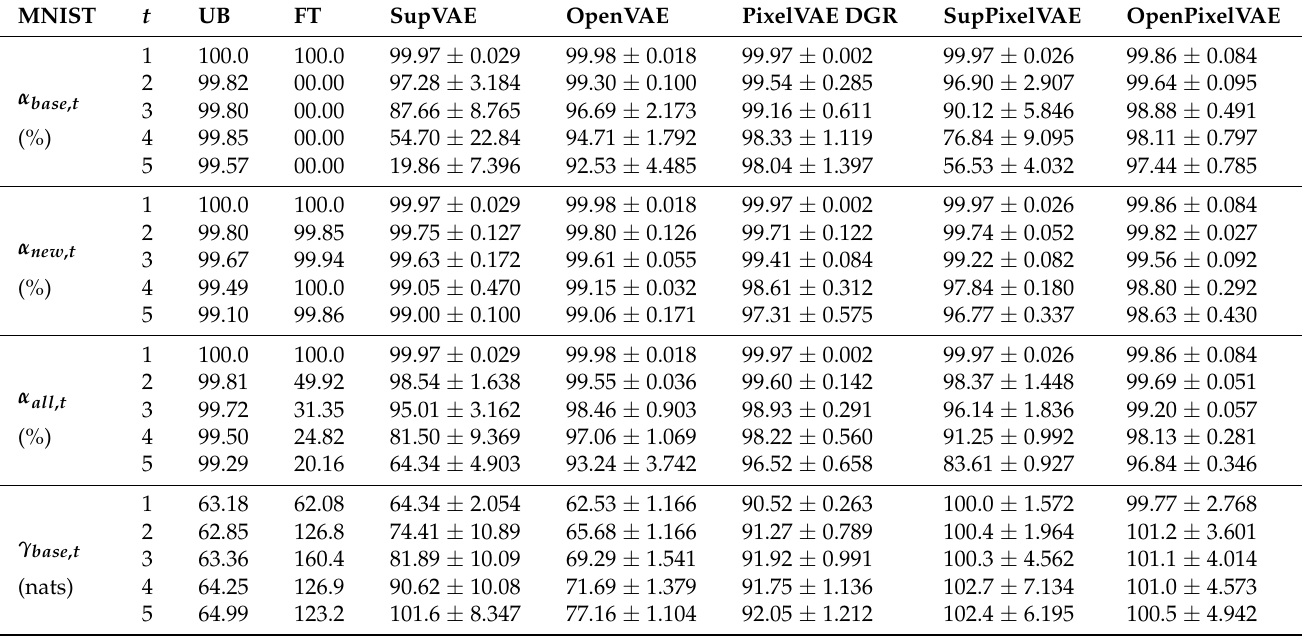
Table A5. The results for class incremental continual-learning approaches averaged over five runs, baselines and the reference isolated learning scenario for MNIST at the end of every task increment. This is an extension of Table 3 in the main body. Here, in addition to the accuracy α t , γ t also indicates the respective negative log-likelihood (NLL) at the end of every task increment t